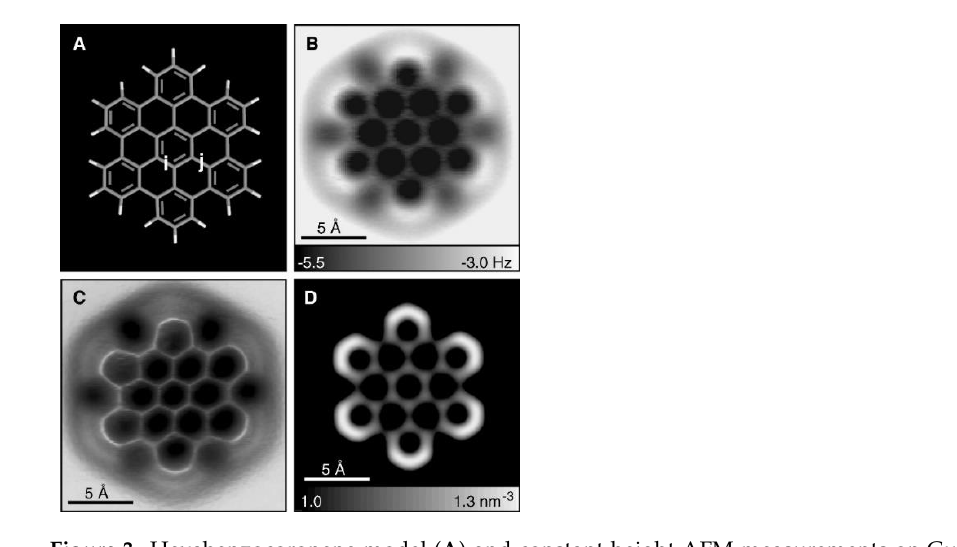
Figure 3. Hexabenzocoronene model ( A ) and constant height AFM measurements on Cu(111) at z = 3.7 Å ( B ) and 3.5 Å ( C ). In ( C ), a pseudo-3D representation is shown to highlight the local maxima. ( D ) Calculated electron density at a distance of 2.5 Å above the molecular plane. Note that i bonds are imaged as brighter ( B ) and shorter ( C ) compared with j bonds. Reprinted from Ref. [19] with permission from AAAS.